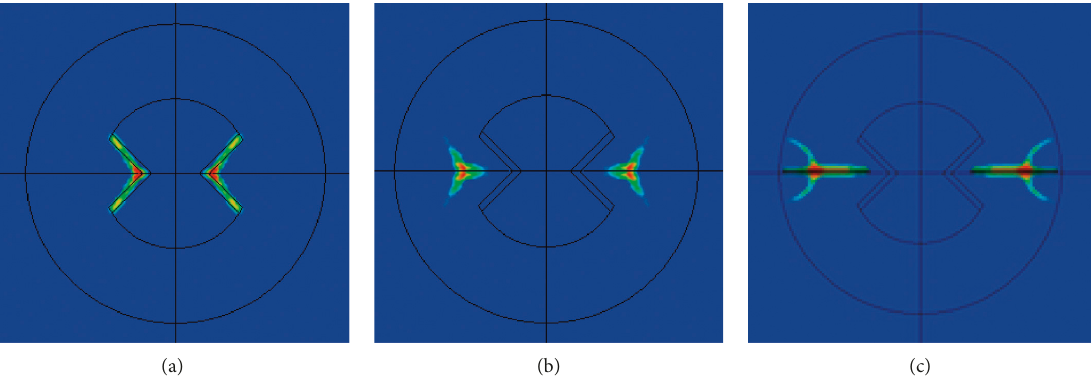
Figure 6: Process of shaped charge jet formation and migration under cumulative blasting with decoupling coefficient 2: (a) t � 4.20 μ s; (b) t � 20.96 μ s; (c) t � 35.79 μ